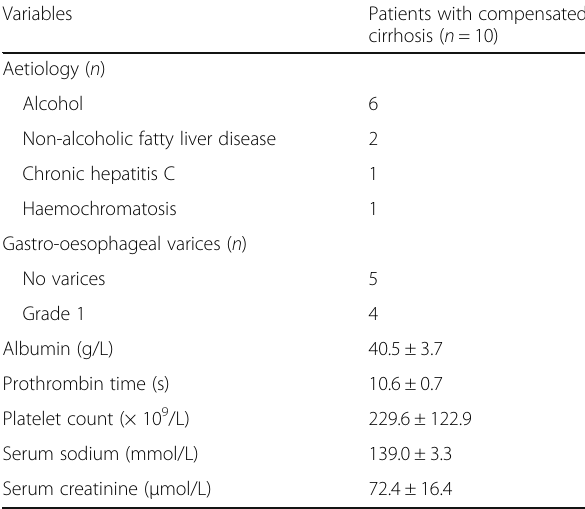
Table 2 Clinical and laboratory data for the patients